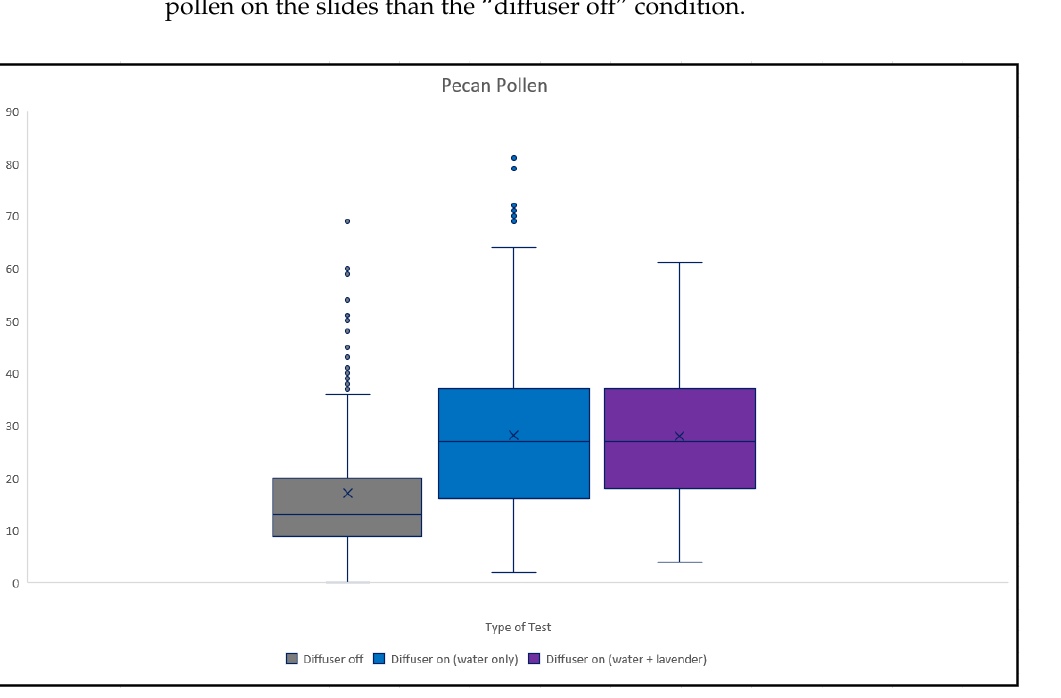
Figure 10. Total pecan pollen counts compared to test type.